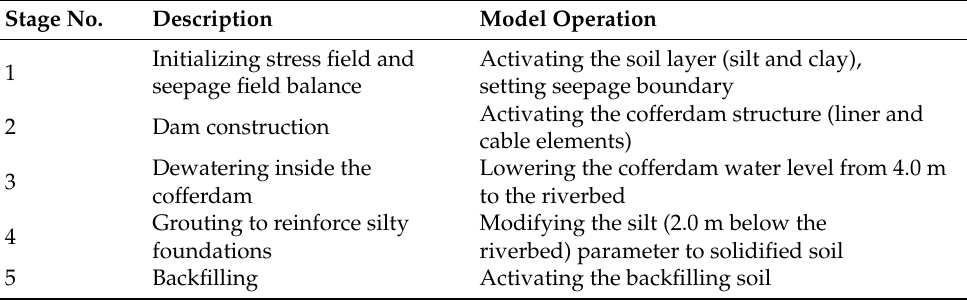
Table 2. Stages of construction in finite difference analysis.